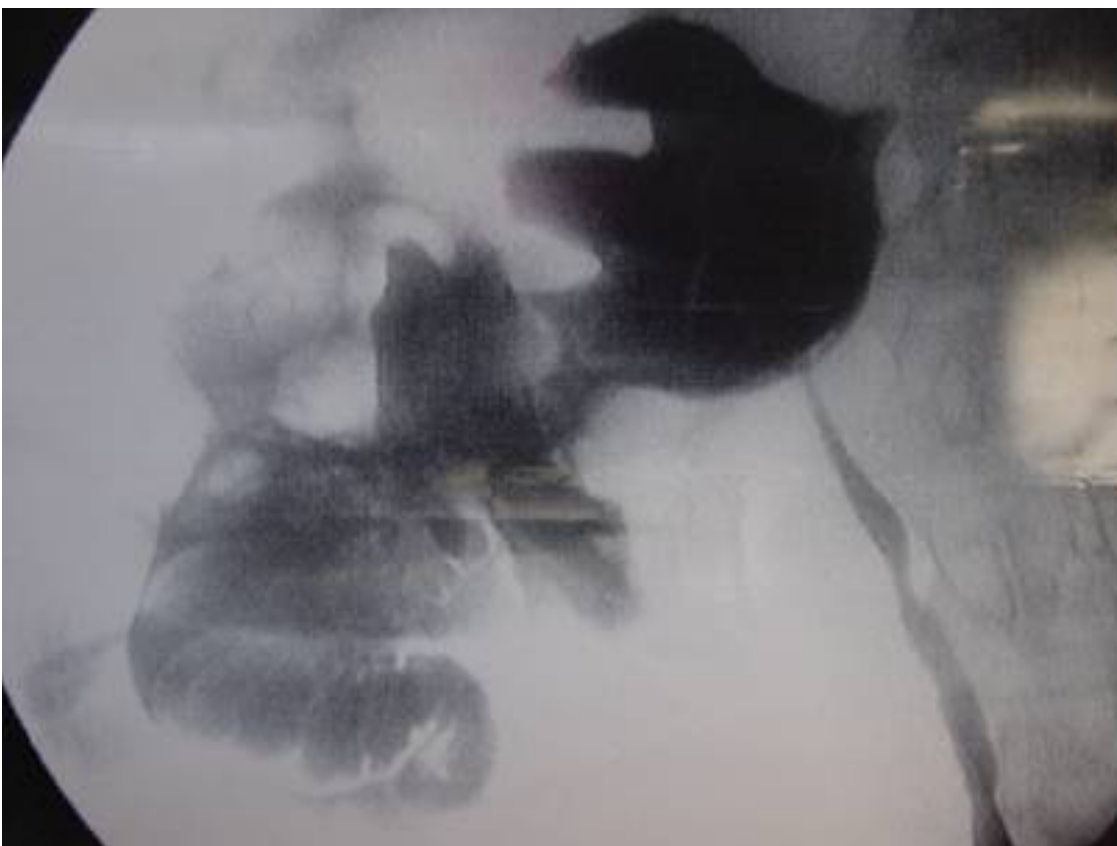
FIGURE 1 . Nephrostogram demonstrates a communication between small bowel and the renal